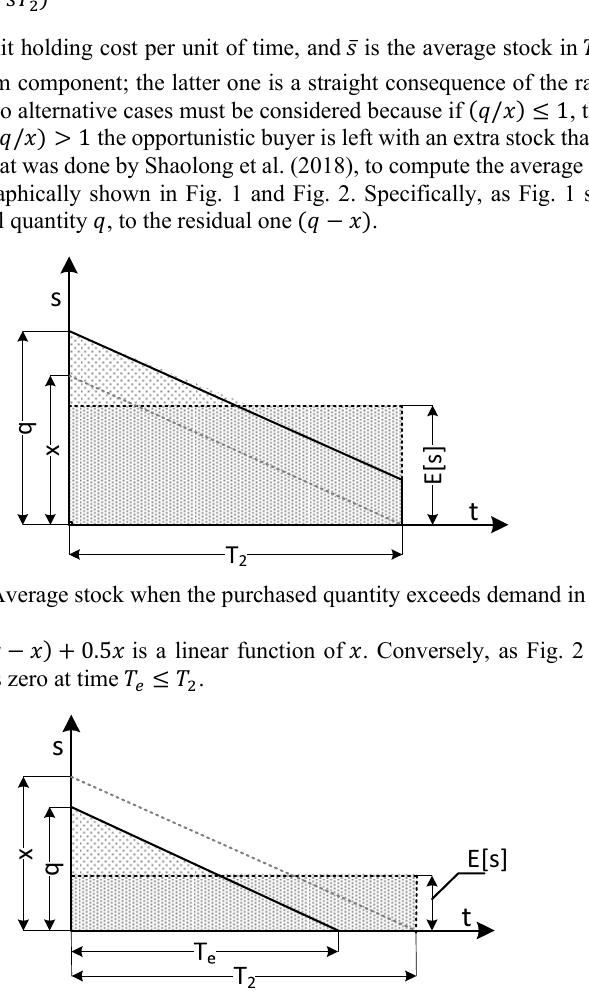
exceeds the purchased (cid:2870)